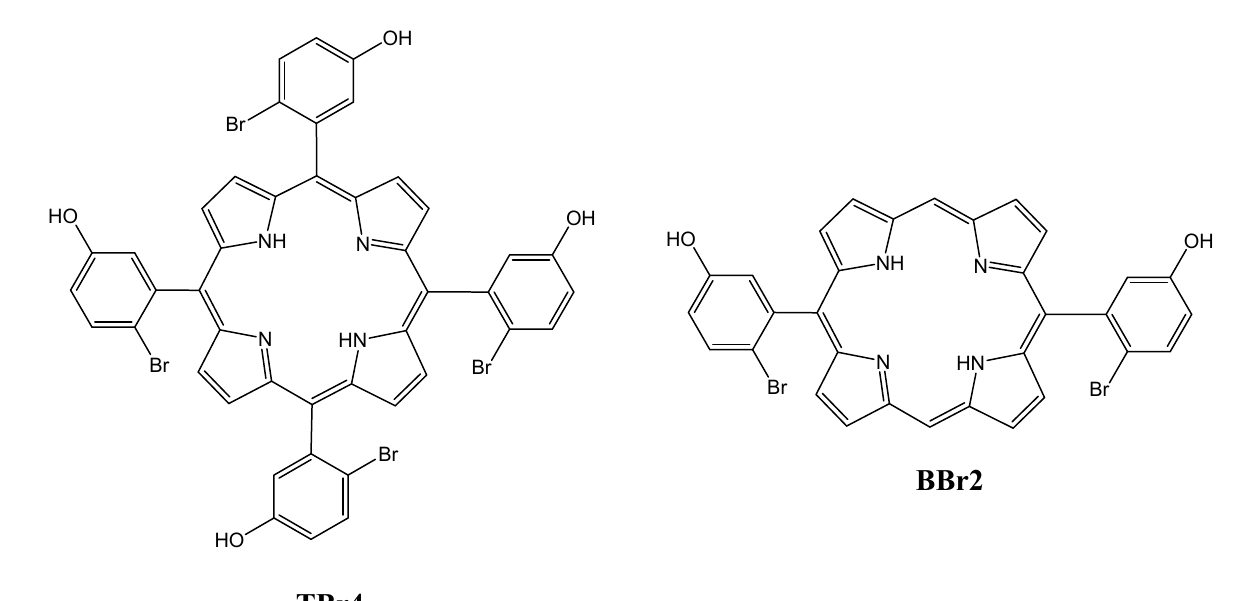
Figure 3. Chemical structures of PS 5,10,15,20-tetrakis(2-bromo-3-hydroxyphenyl)porphyrin (TBr4) and 5,15-bis(2-bromo-3-hydroxyphenyl)porphyrin (BBr2) [50].